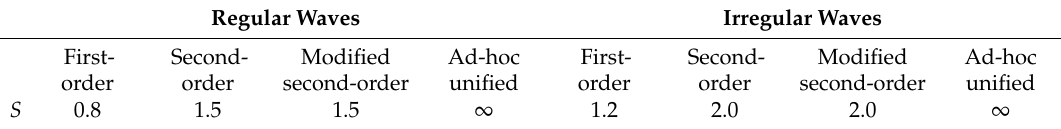
Table 2. Applicability of each tested wavemaker